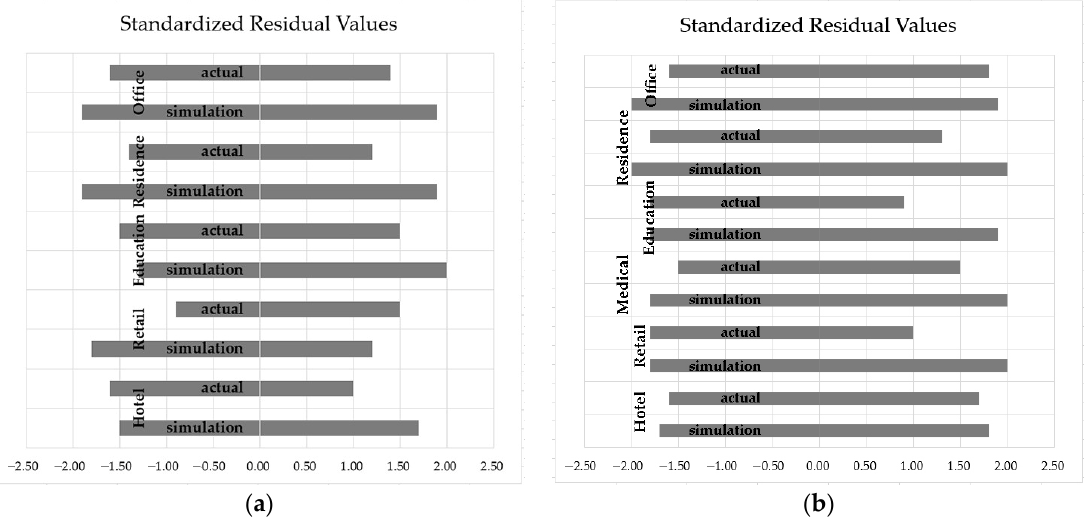
Figure 8. The standardized residual values for validation. ( a ) Electricity EUI; ( b ) heating EUI.